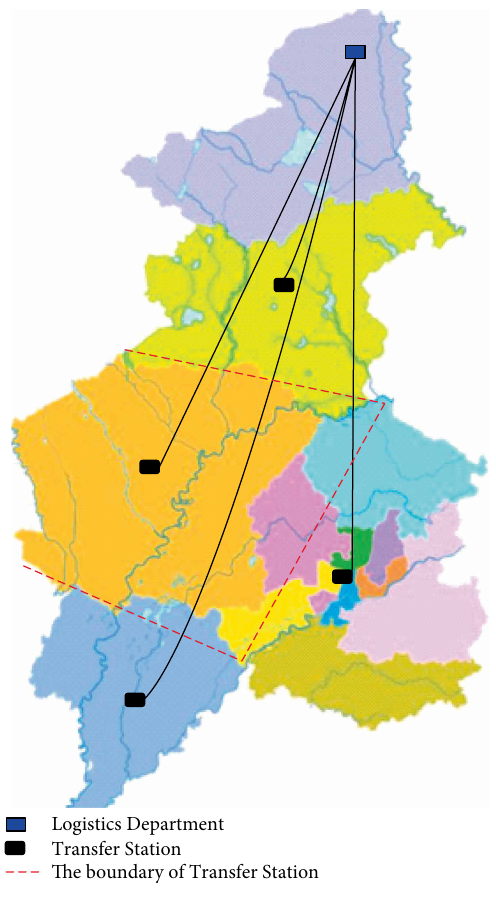
Figure 2: Distribution diagram for the last